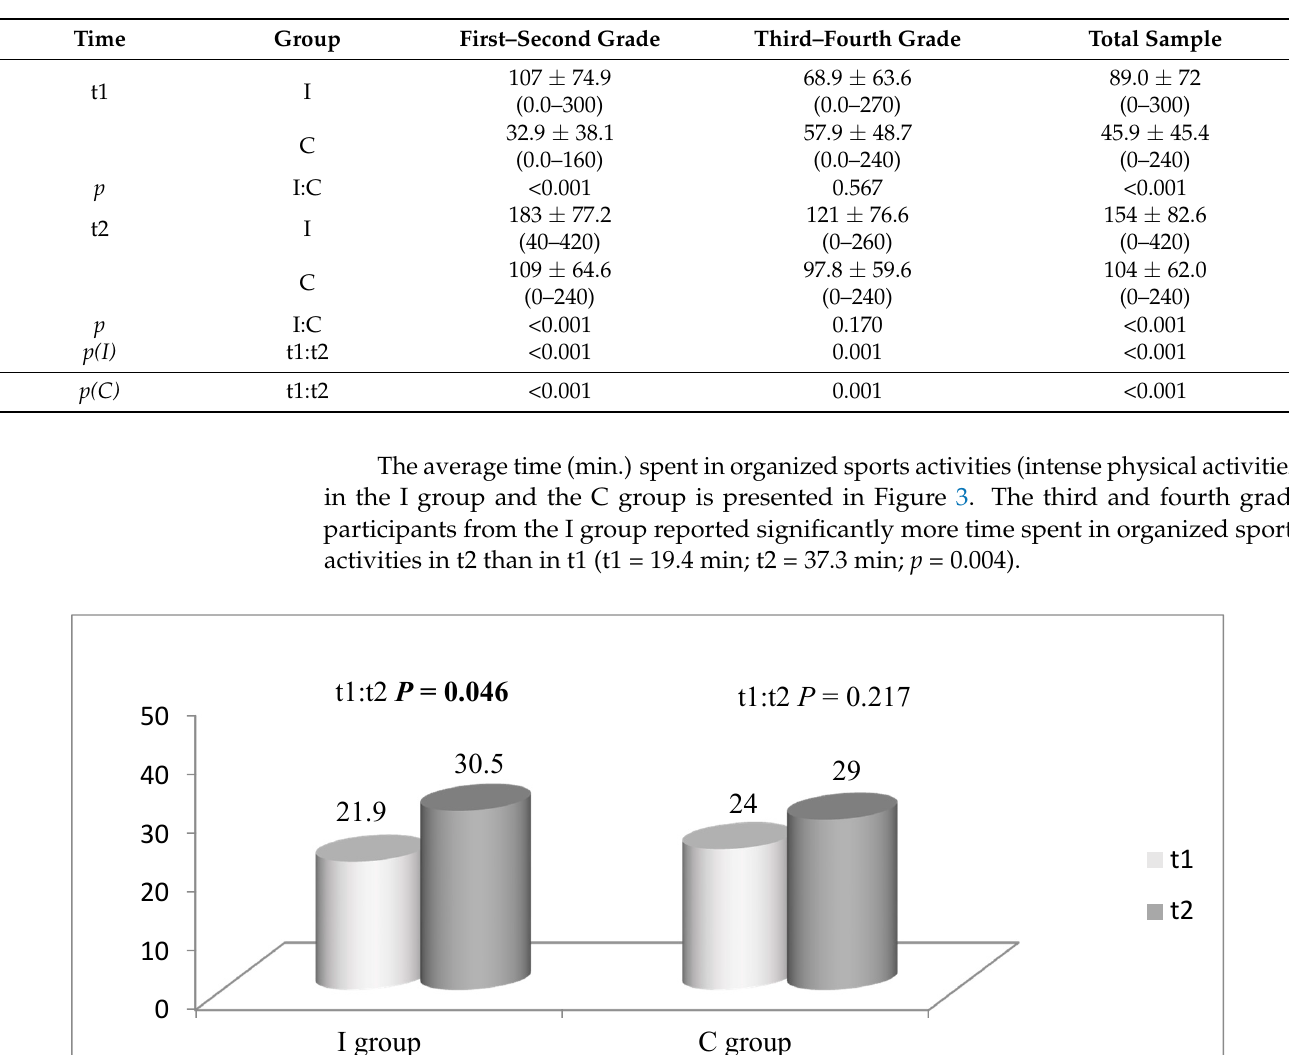
Table 4. Average time (min.) spent playing outside (moderate physical activities) in the I group and the C group in t1 and t2. Table 4 shows average time (min.) spent playing outside (moderate physical activities) in the I group and the C group in t1 and t2.